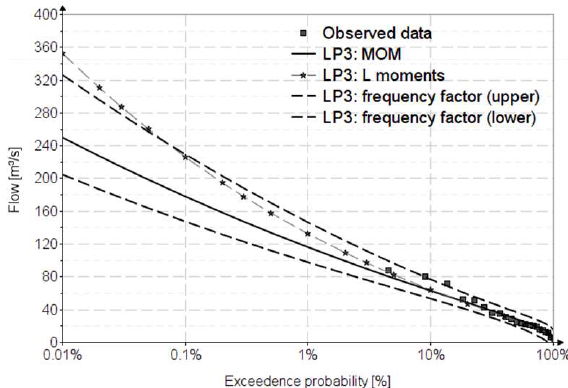
Figure 9. LogPearson III distribution.